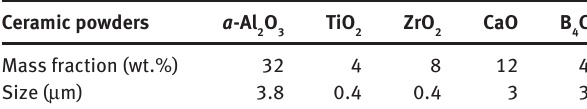
Table 3: Composition and proportion of ceramic powders. Ceramic powders